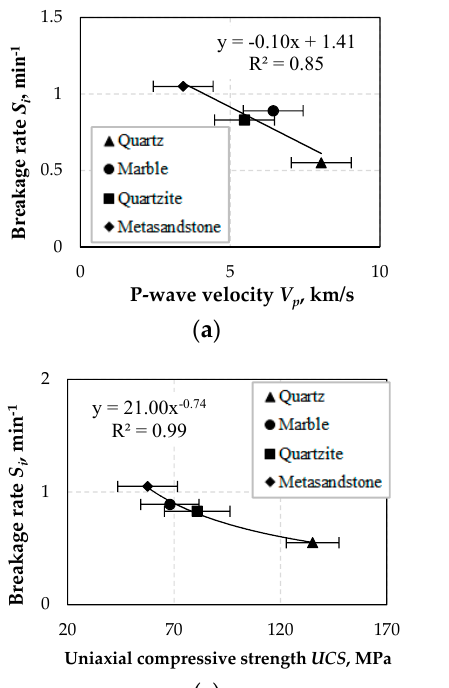
Figure 10. Correlations between breakage rate S i and ( a ) P-wave velocity V p , ( b ) Schmidt rebound values R L , ( c ) uniaxial compressive strength UCS and ( d ) tangent modulus of elasticity E t ; horizontal error bars show standard deviation of the measurements.